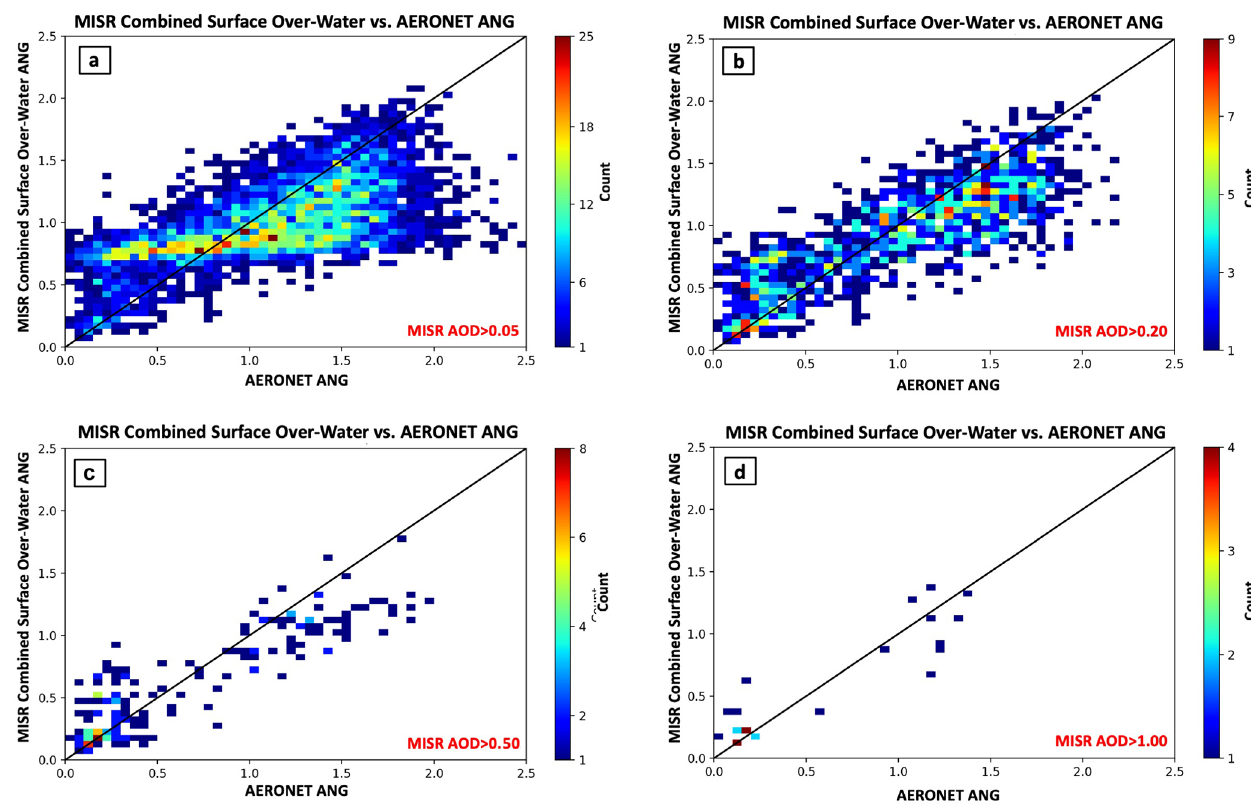
Figure 8. Same as Fig. 4, except for the MISR over-water